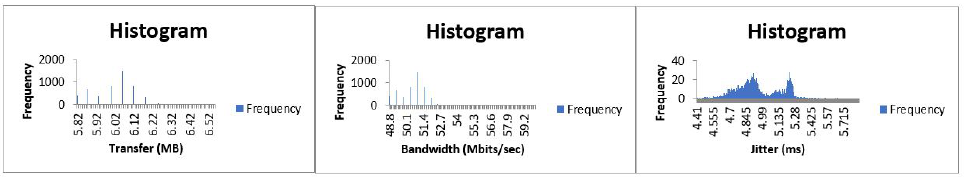
Figure 15. Node 3 with high data rate transferred utilized bandwidth and